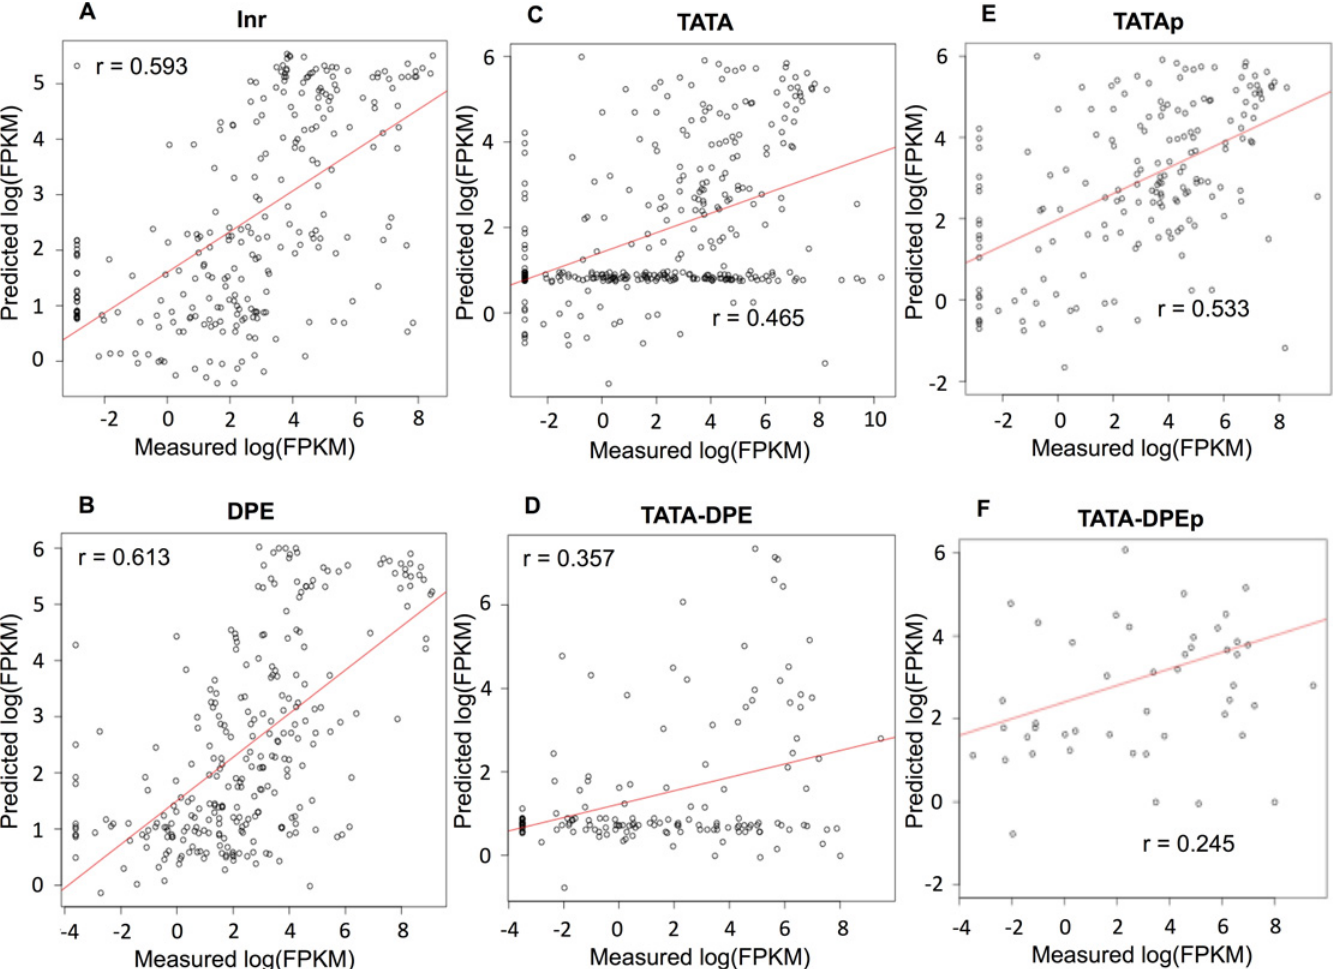
Fig 3. Comparison of the histone modification dependency of RNA expression values by linear regression. Ten-fold cross validation was performed to check that the regression equations reflected the general relationship between the histone modification ratio and the measured log(FPKM) obtained by RNA-seq. The correlation between the measured and predicted log(FPKM) has been represented by a scatterplot. (A) Scatterplot between the measured and predicted log(FPKM) in the Inr group ( n = (24 core promoters ) × (11 developmental stages ) = 264). The correlation coefficient was r = 0.593. (B) Scatterplot between the measured and predicted log(FPKM) in the DPE group ( n = (25 core promoters ) × (11 developmental stages ) = 275). The correlation coefficient was r = 0.613. (C) Scatterplot between the measured and predicted log(FPKM) in the TATA group ( n = (33 core promoters ) × (11 developmental stages ) = 363). The correlation coefficient was r = 0.465. (D) Scatterplot between the measured and predicted log(FPKM) in the TATA-DPE group ( n = (14 core promoters ) × (11 developmental stages ) = 154). The correlation coefficient was r = 0.357. The TATA and TATA-DPE groups were divided into two types based on the distributions in the scatterplots. (E) Scatterplot between the measured and predicted log(FPKM) in the TATAp group (n = 189, for details see the Methods). The correlation coefficient was r = 0.533. (F) Scatterplot between the measured and predicted log(FPKM) in the TATA-DPEp group (n = 51, for details see the Methods). The correlation coefficient was r =